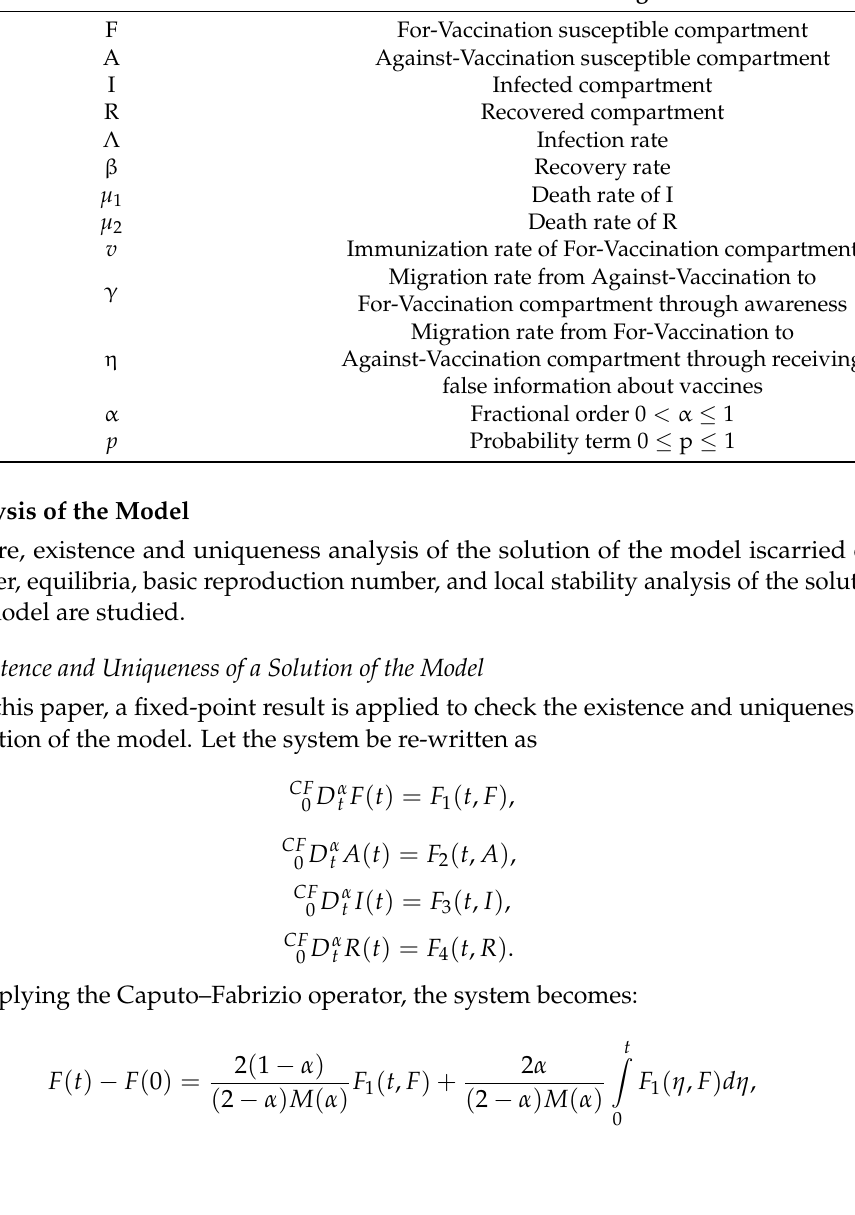
Table 1. Meaning of parameters.